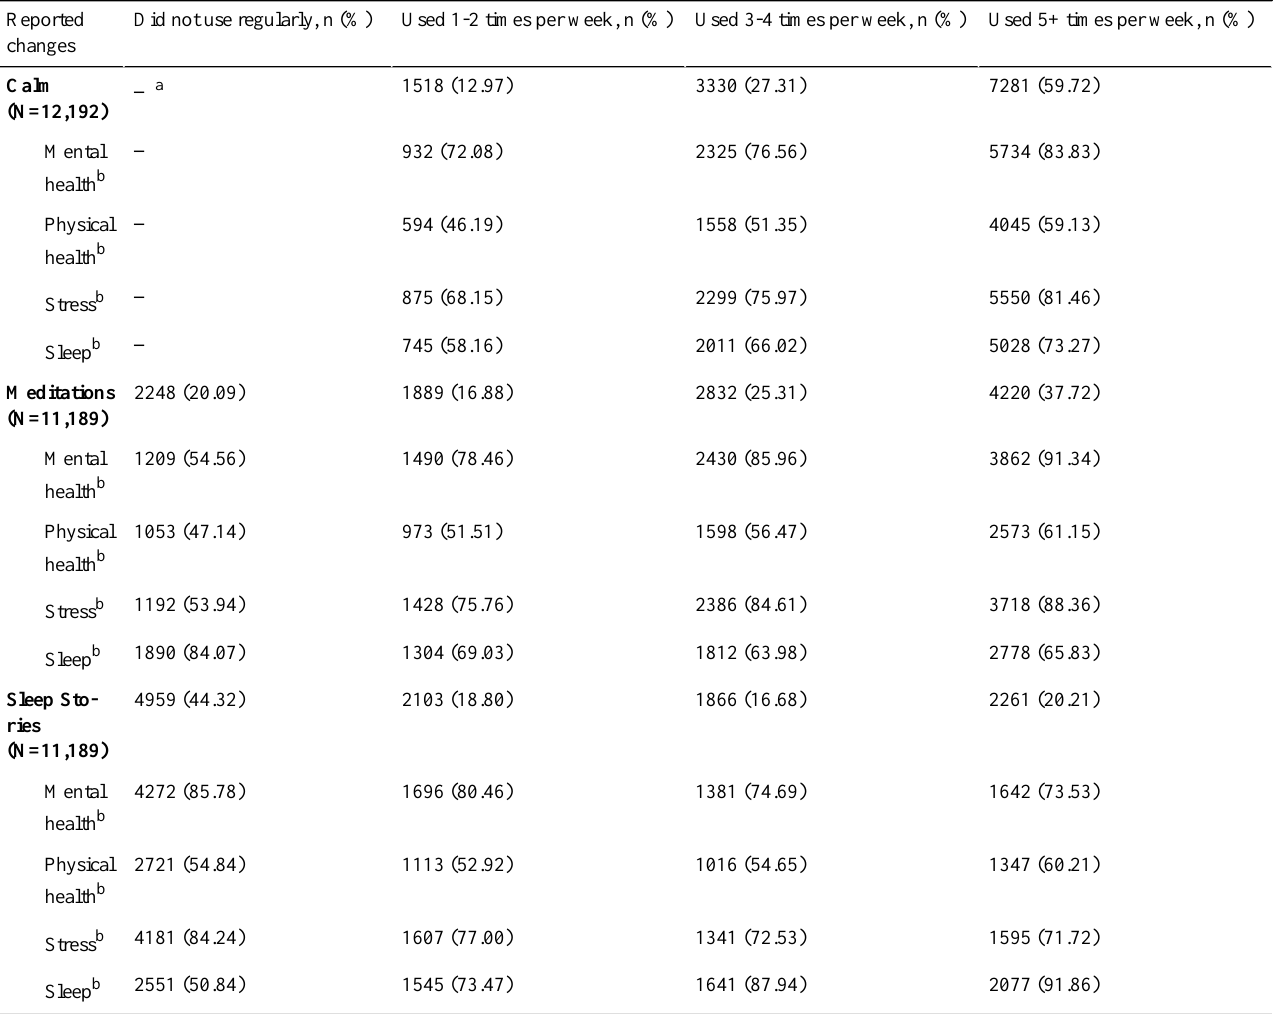
Table 7. Differences in noticing changes in mental health, physical health, stress, and sleep based on frequency of using